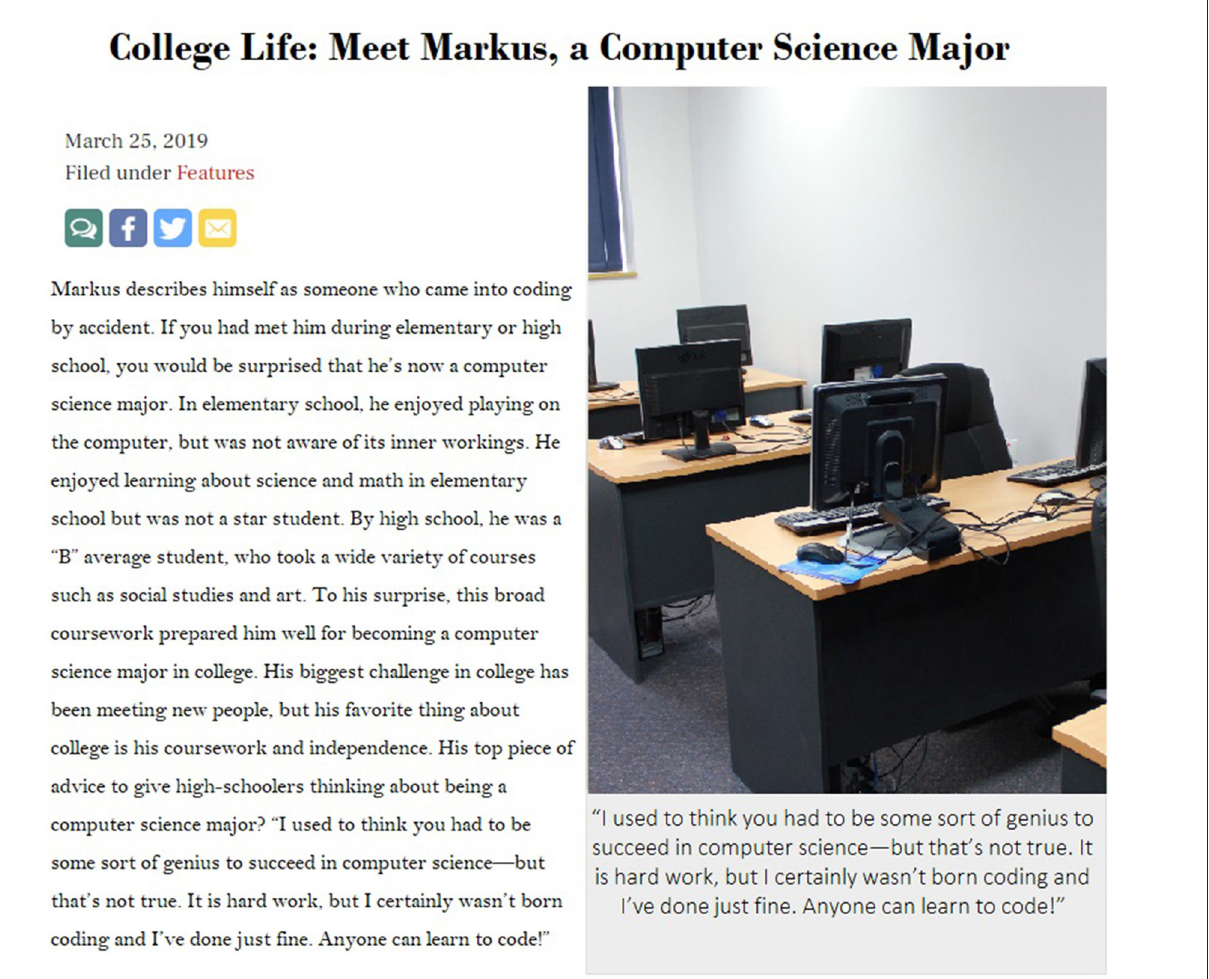
FIGURE 2 | Control condition